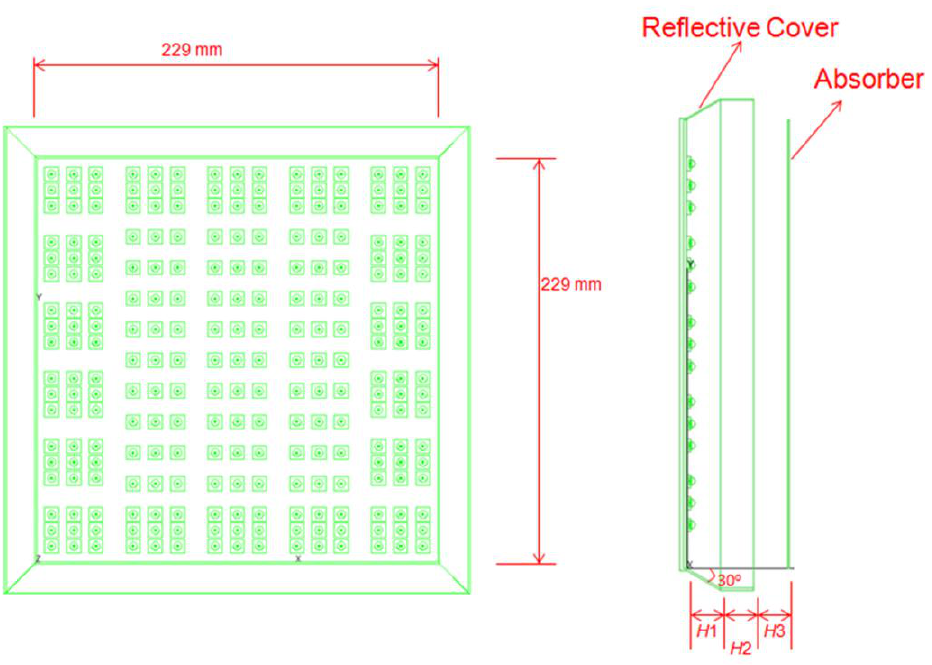
Figure 22. The final LED arrangement.